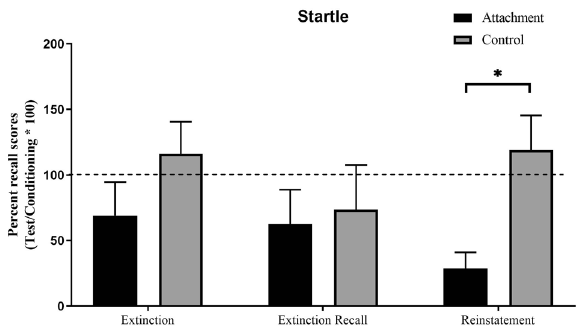
Fig. 4 Percent recall scores of startle data across the three phases of extinction learning, extinction recall and reinstatement test. Recall scores were calculated for each participant by taking their average differential score (CS + minus CS − ) during the extinction, recall and reinstatement phases, dividing by their average differ- ential score during fear conditioning and multiplying by